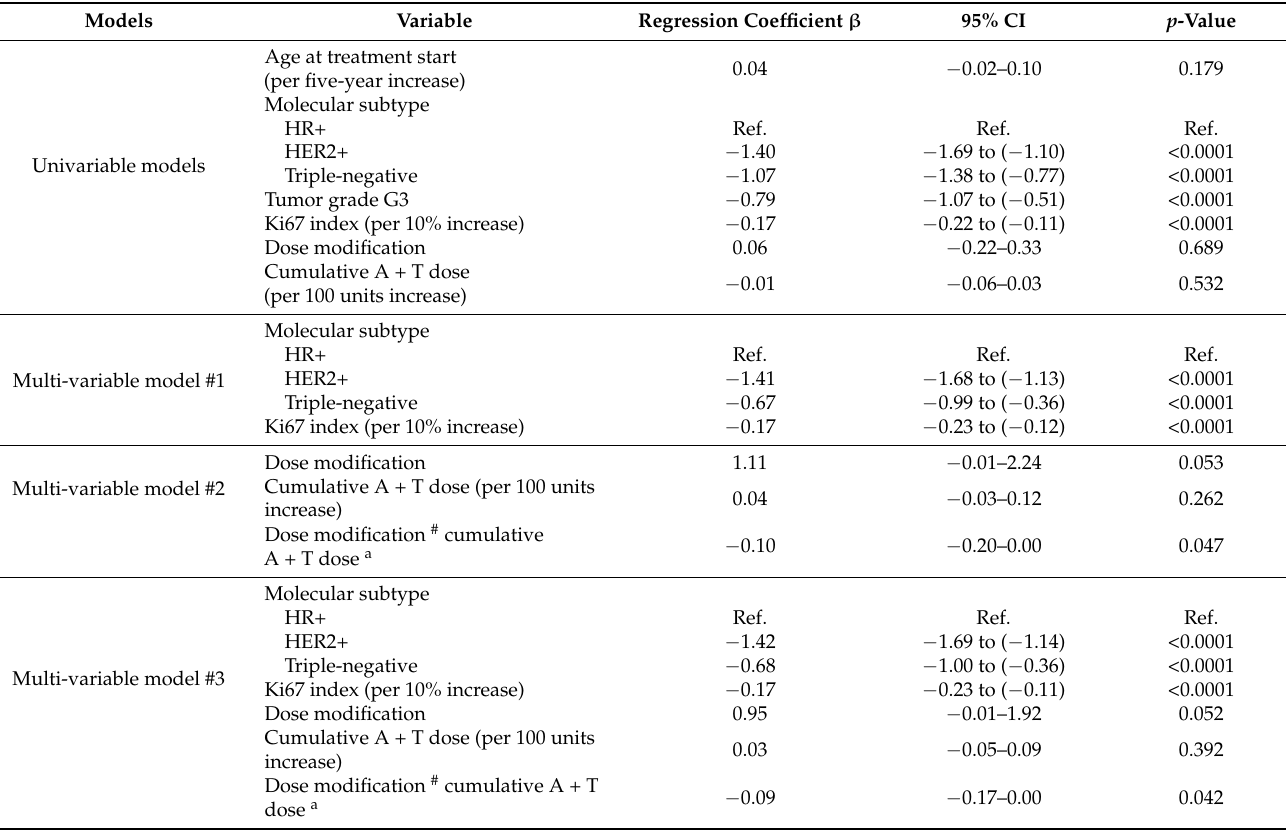
Table 3. Univariable and multivariable regression models investigating predictors of the RCB